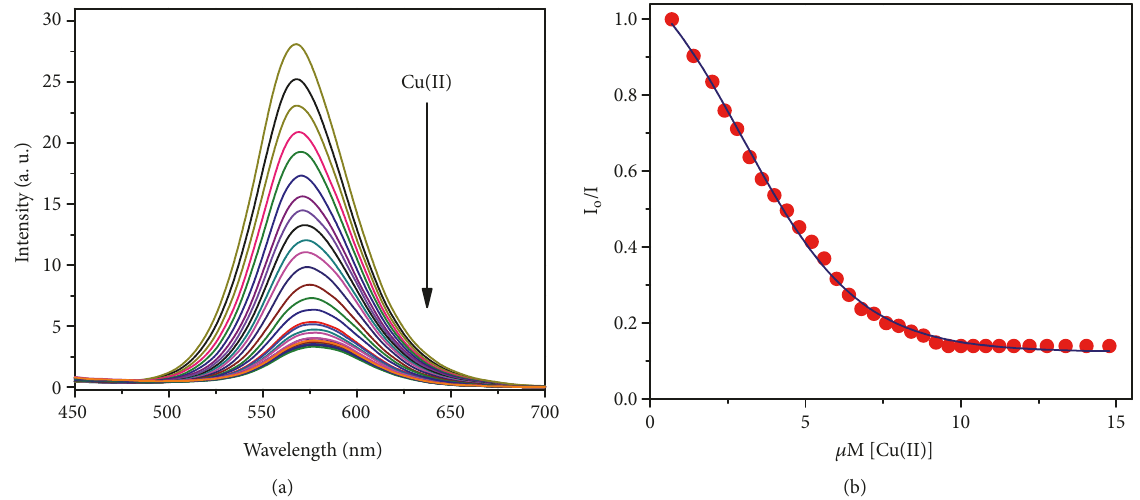
Figure 4: Fluorescence emission spectra of BDC 10 𝜇 M in 1:9 Methanol HEPES buffer solution (pH = 7.2) during gradually addition of Cu(II) ions within range of 0-15 𝜇 M, under excitation with 401